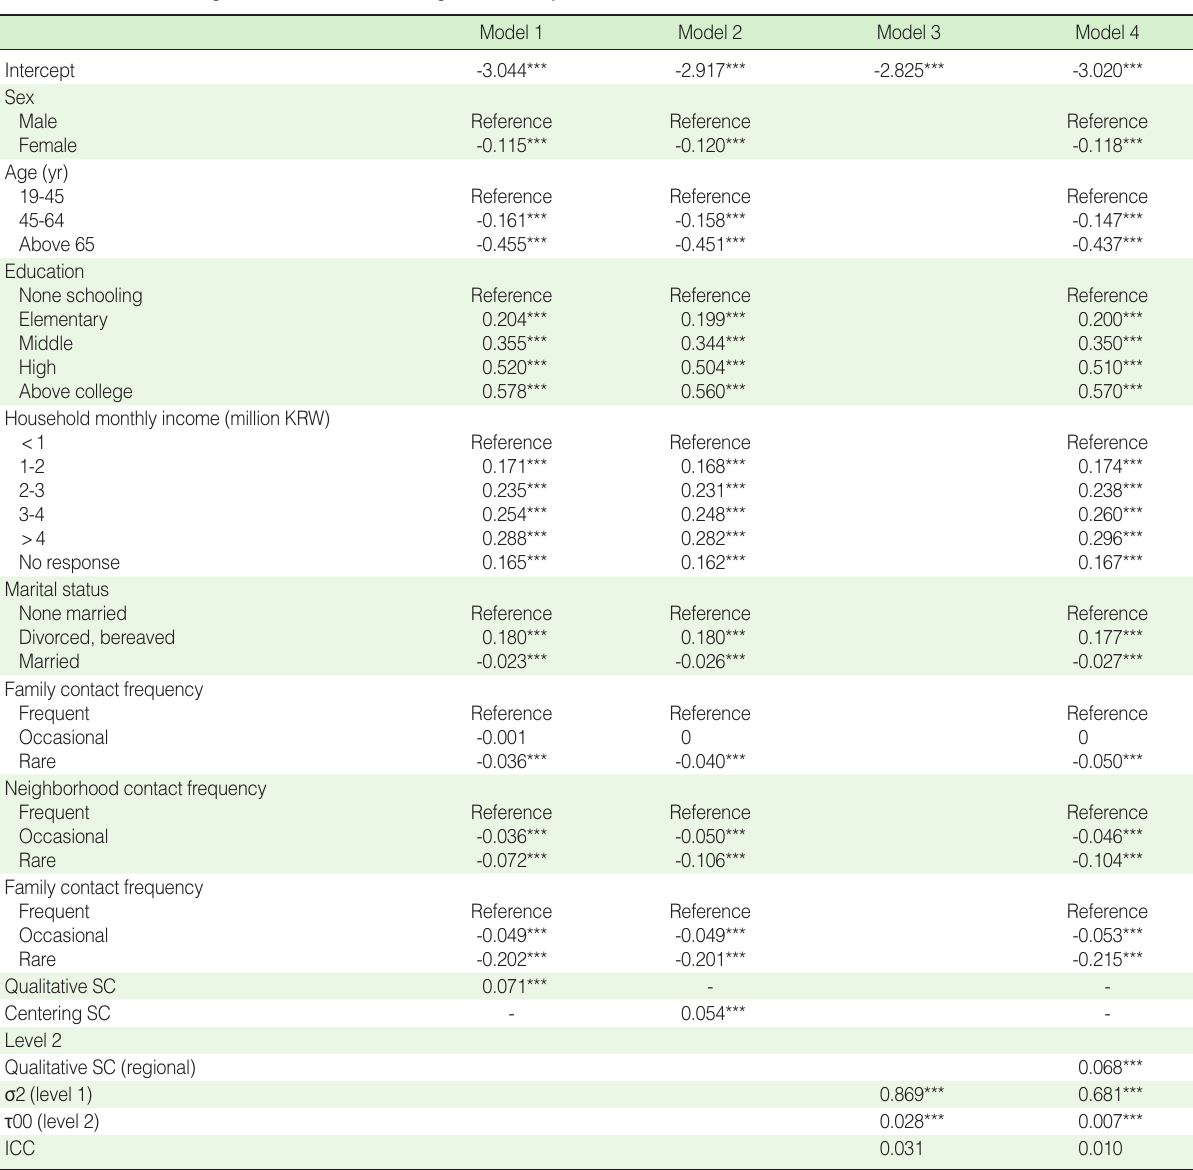
Table 4. Estimates of single-level and multi-level regression